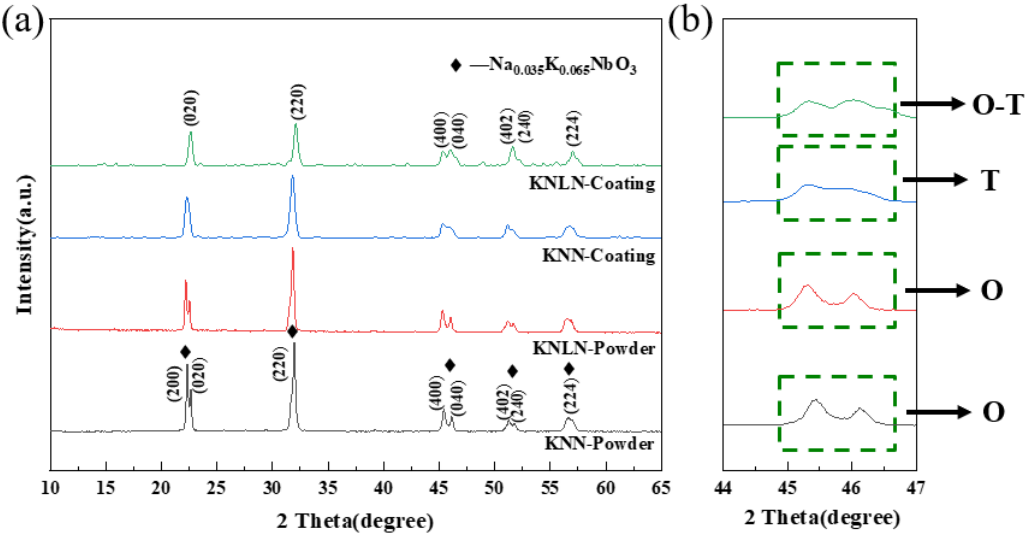
Figure 2. ( a ) X-ray diffraction (XRD) patterns of the KNN and KNLN powders and coatings; ( b ) enlarged XRD patterns in the range of 2 θ from 44° to 47°. larged XRD patterns in the range of 2 θ from 44 ◦ to 47 ◦